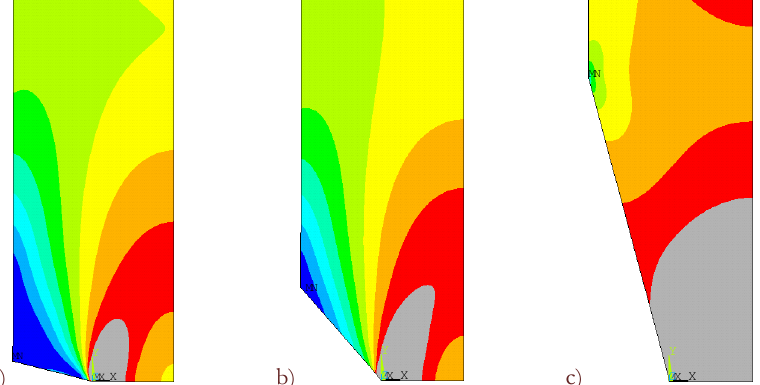
Figure 4: Distribution of von Mises stress ahead of V-notch tip in duraluminum sample. The plastic zone is marked by grey colour. Numerical calculations were performed for V-notch opening angle: a) α =10°, b) α =40° and c) α =70°. The remote applied tensile load corresponded to the critical